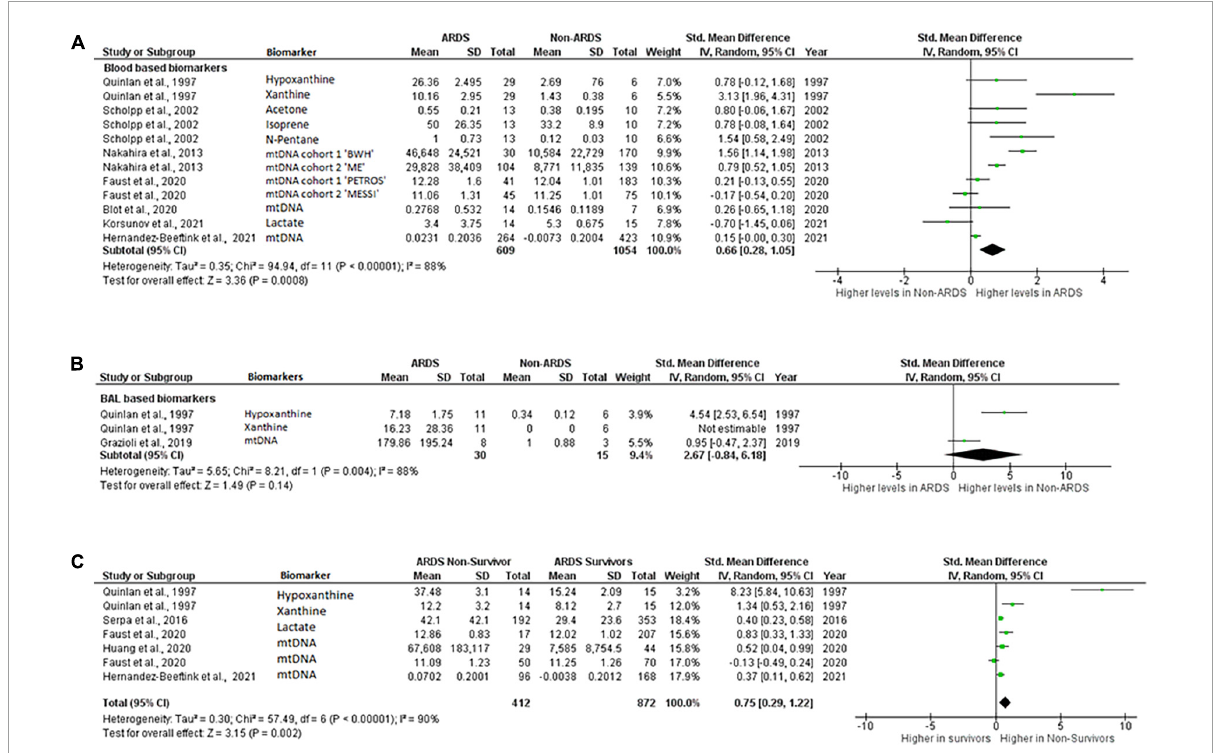
FIGURE2 Levels of biomarkers of mitochondrial dysfunction. Forest plot meta-analysis of the levels of biomarkers in ARDS patients and non-ARDS controls in (A) blood samples P = 0.008 and (B) BAL samples P = 0.14 (C) ARDS survivors vs ARDS non-survivors, P = 0.002. Data analysis generated on RevMan 5.4.